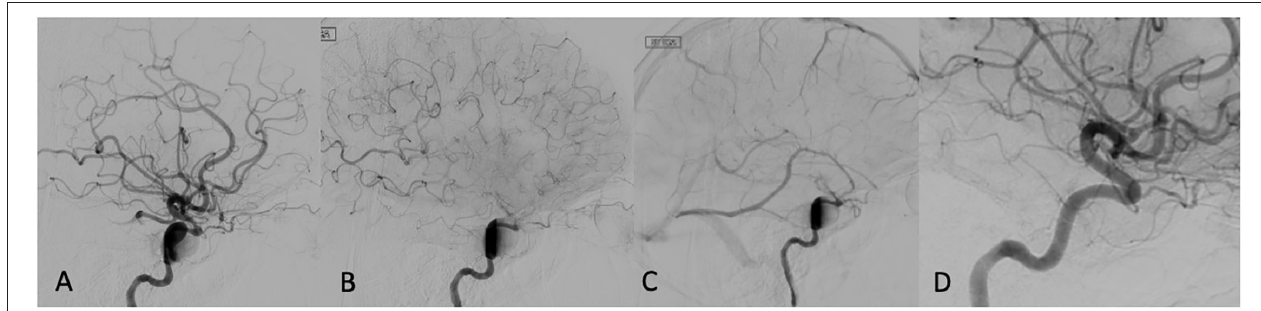
FIGURE 2 | Immediate post FD angiogram: first appearance of eclipse sign in late arterial phase (A) persisting through capillary (B) , and venous phases (C) . A 12-months follow-up showing complete aneurysm disappearance (D) .